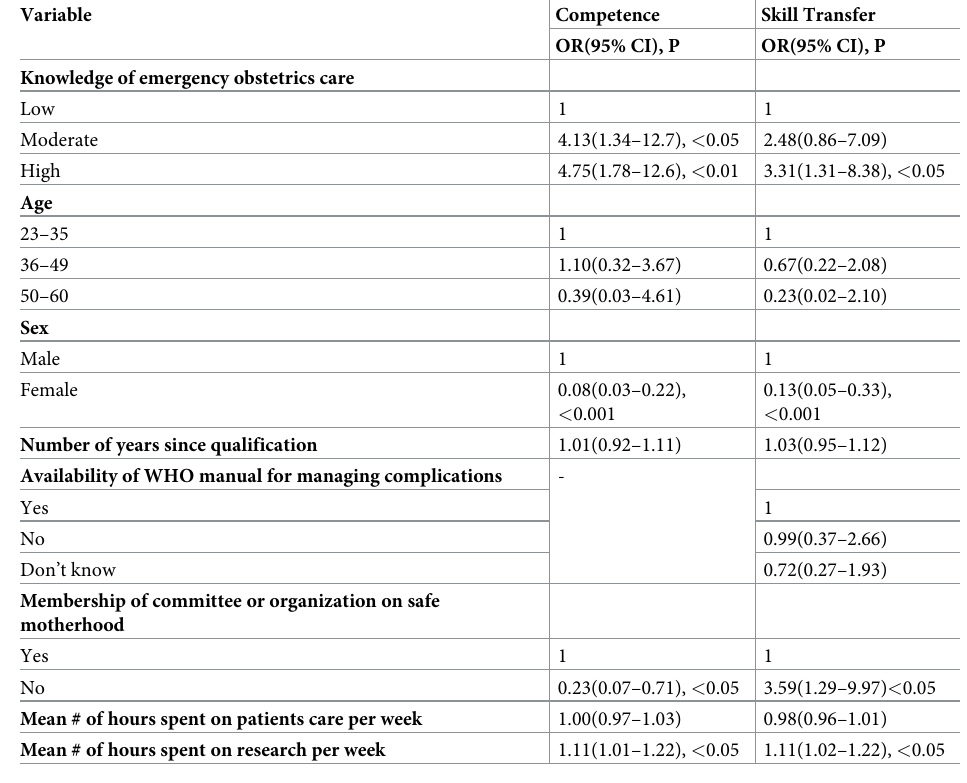
Table 4. Predictors of competence and transfer of clinical